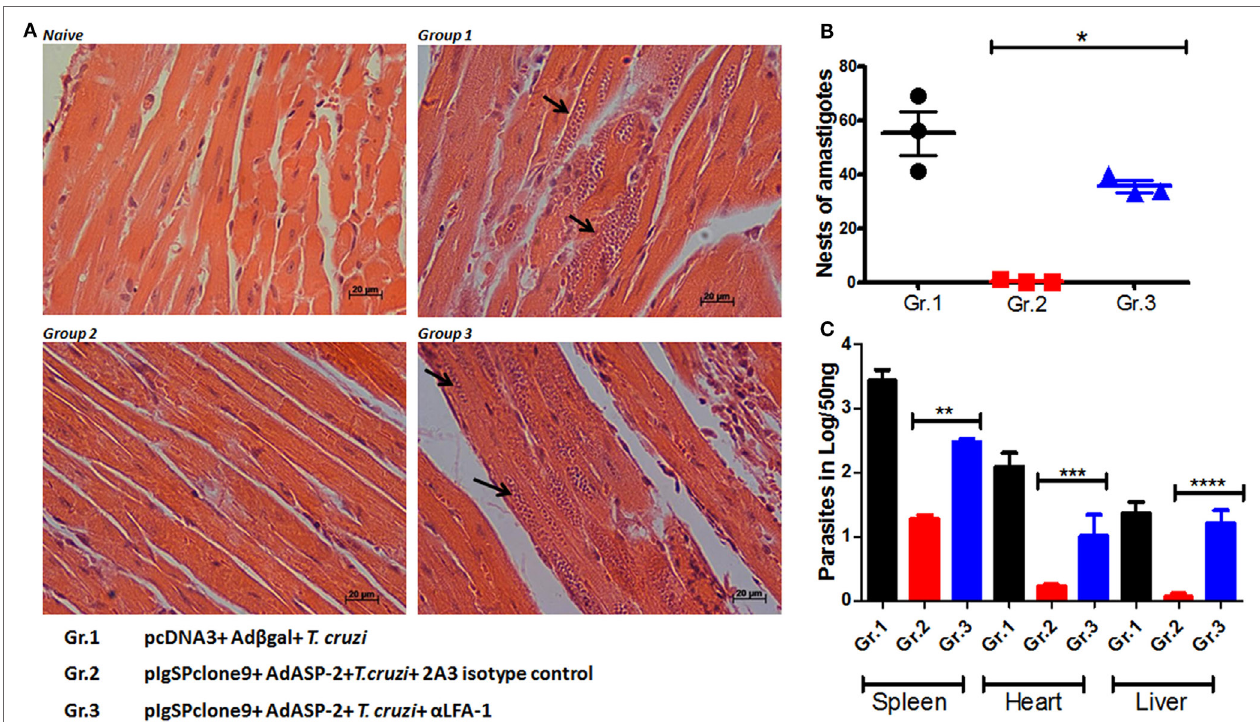
FigUre 2 | Treatment with anti-LFA-1 increases tissue parasitemia. A/Sn mice were immunized with ASP-2 using the heterologous “prime-boost” vaccination regimen, infected with 150 trypomastigotes forms of Trypanosoma cruzi and treated with anti-LFA-1 or isotype control until the 20th after infection. In this day, spleens, hearts, and livers of this mice were taken for quantification of the parasite DNA and count of amastigote nests in the heart. (a) Histological section of the heart; the arrows indicate the amastigote nests in each group. (B) Quantification of heart amastigote nests performed from 50 fields/group. (c) Quantification of the parasite DNA by real-time PCR in the different groups (Log) obtained from 50 ng of tissue DNA. Results represent mean ± SD for each group ( n = 4) and to a single experiment. Asterisks represent statistical differences among the groups. Statistical analysis was performed using one-way ANOVA (* P < 0.001, ** P = 0.000331, *** P = 0.006602, and **** P <